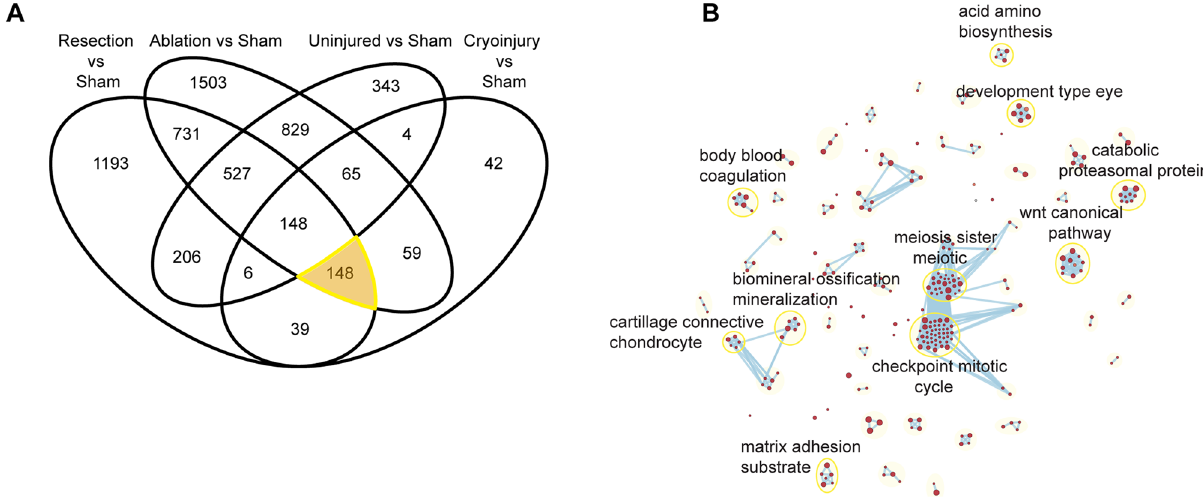
Figure 4. Biological pathways enriched in the core regeneration DEG set. ( A ) Venn diagram of the Mus musculus converted genes from the DEG analysis. Highlighting the converted genes involved in the “core regeneration” process of a heart injury despite the model used. ( B ) Gene Ontology Biological Processes associated to these genes when performing annotation and the clustering of these in a